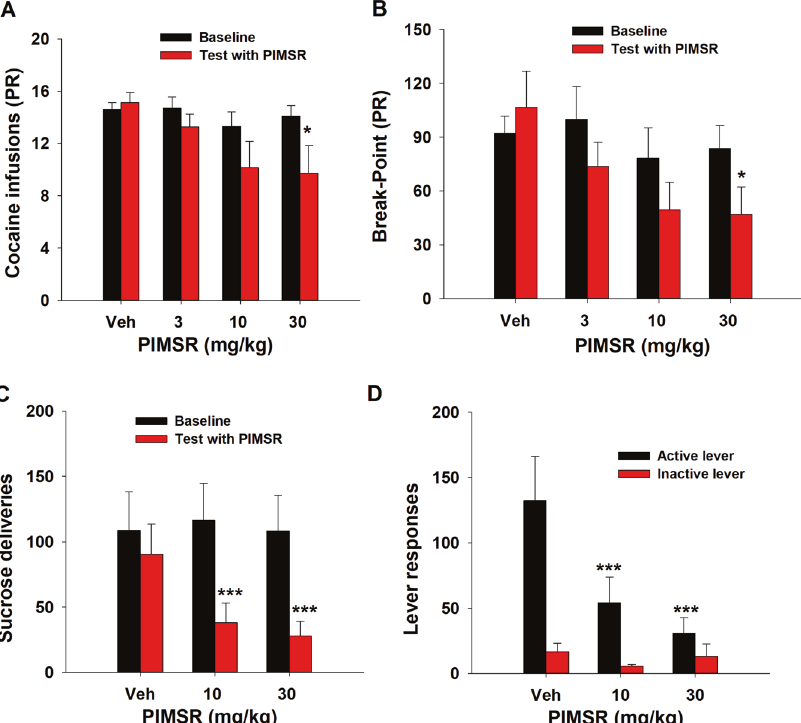
Fig. 2 The effect of PIMSR on PR cocaine self-administration and FR1 oral sucrose self-administration. A , B PIMSR inhibited cocaine self- administration under PR reinforcement in a dose-dependent manner ( n = 7), as assessed by the number of cocaine infusions ( A ) and break- point ( B ). C , D PIMSR dose-dependently inhibited oral sucrose self-administration under FR1 reinforcement ( n = 6), as assessed by the number of sucrose deliveries ( C ) and active lever responses ( D ). PIMSR did not alter inactive lever responses. * p < 0.05, *** p < 0.001, com p ared to